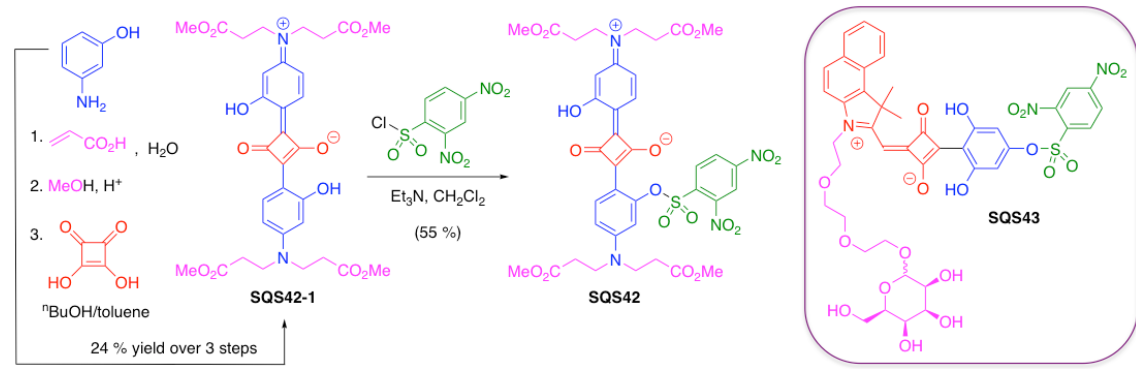
Scheme 17. Synthesis of caged SQS42 [125] and structure of water-soluble, caged SQS43 [126].